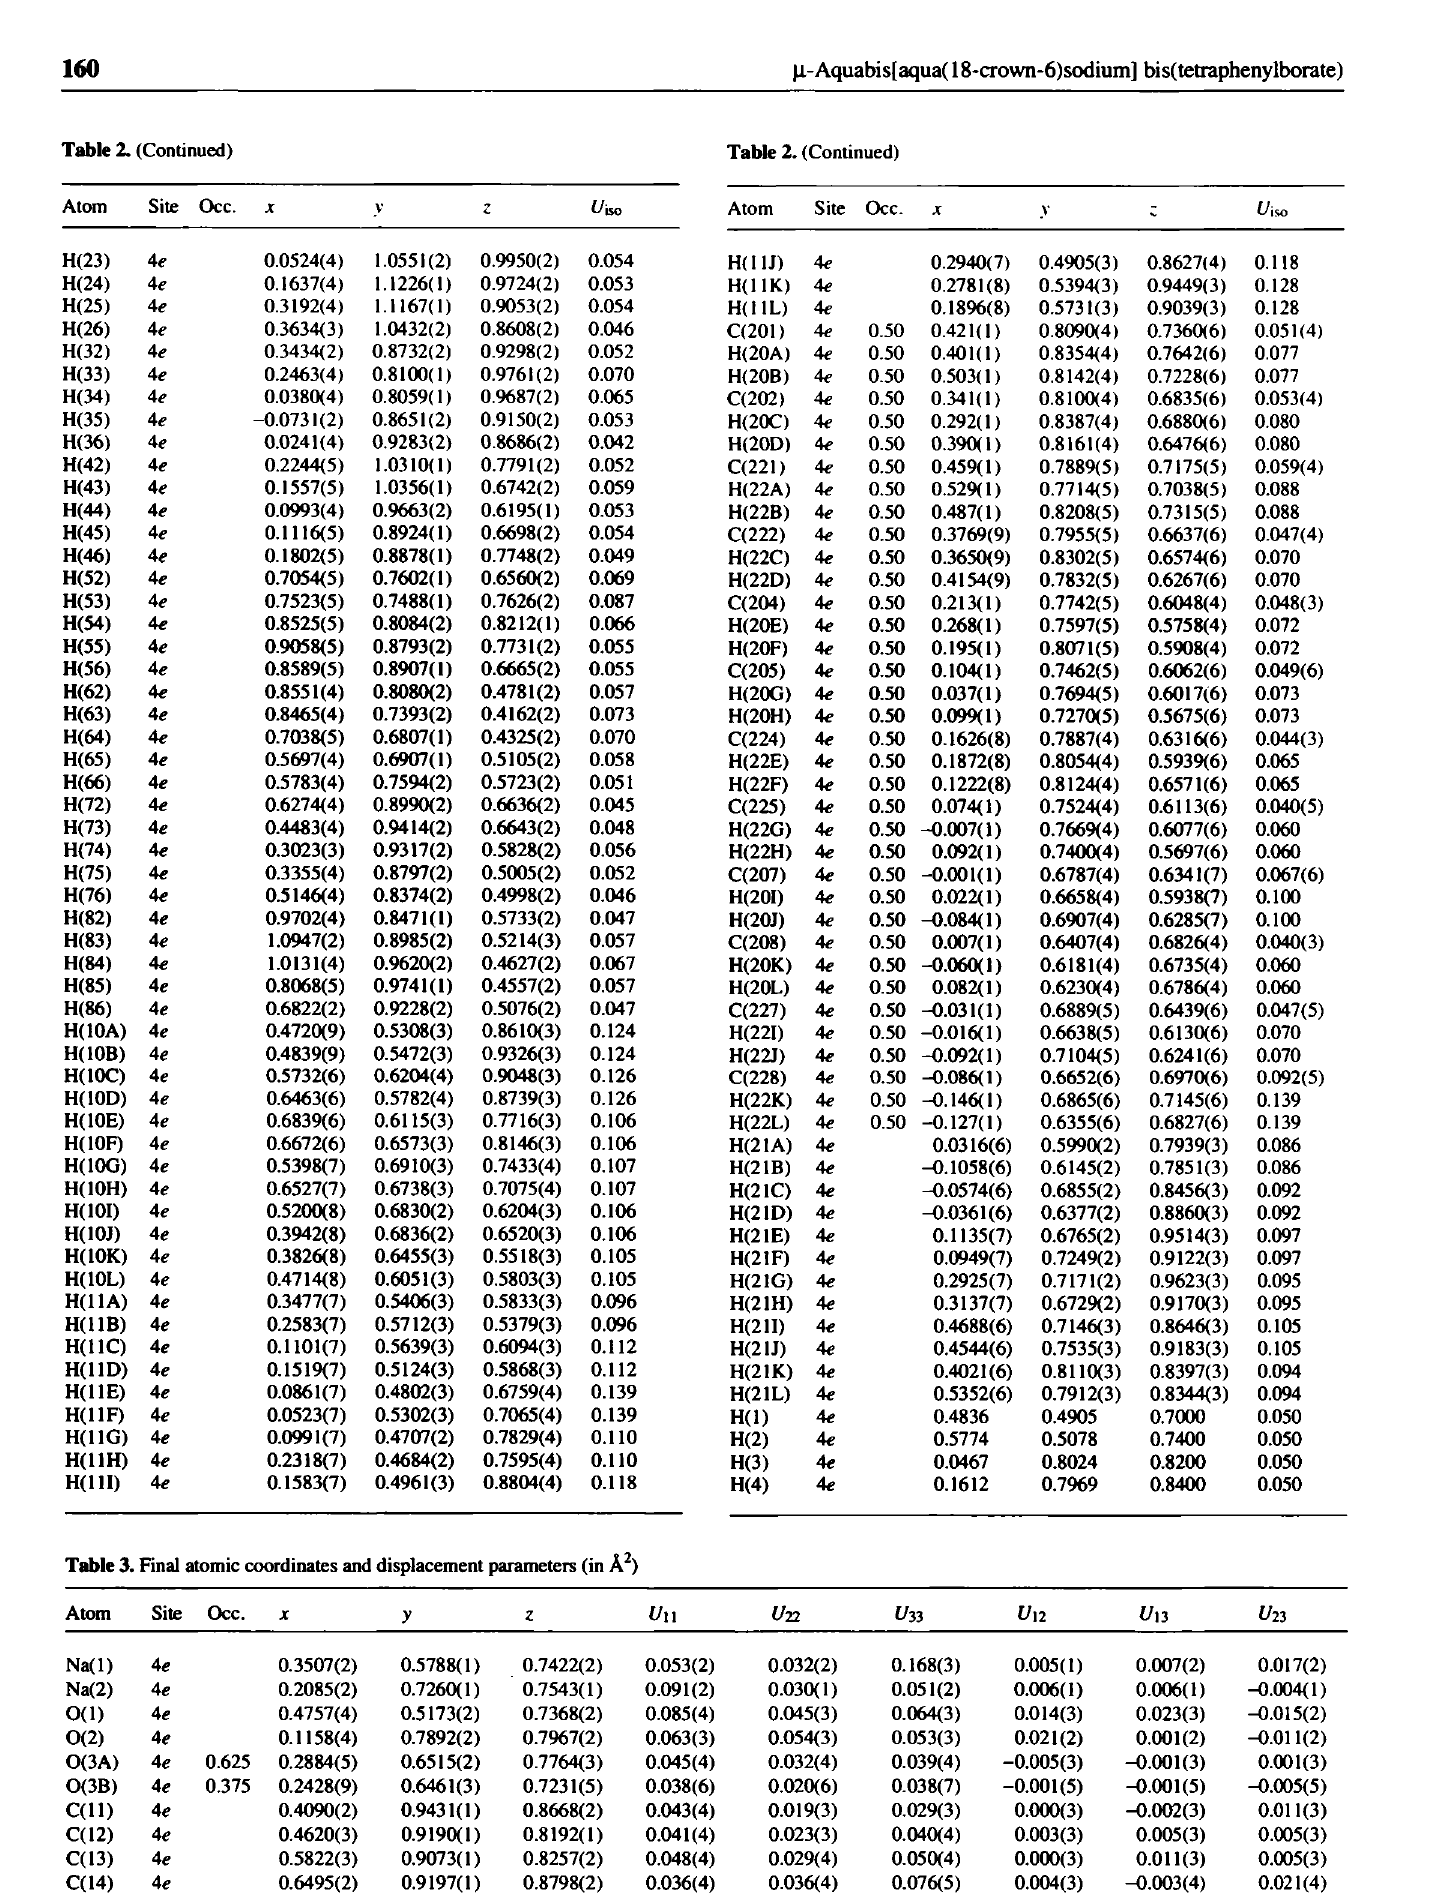
Table 3. Final atomic coordinates and displacement parameters (in A^) Atom Site